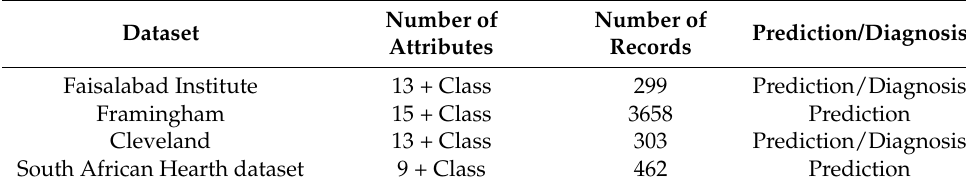
Table 1. Review of Heart Disease